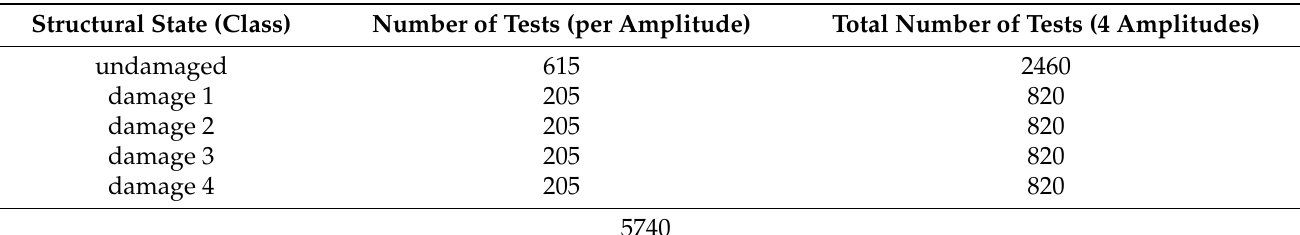
Table 2. Labels, number of tests per amplitude and total number of tests for each